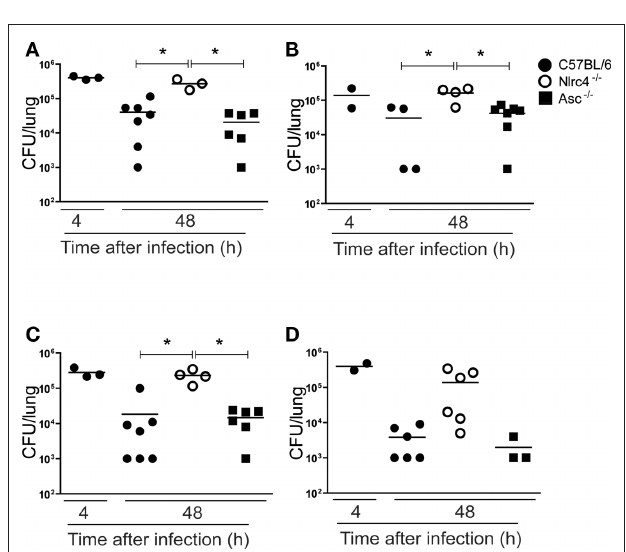
Figure 1 | Caspase-1 contributes for restriction of in vivo infection with L. micdadei , L. bozemanii , L. gratiana, and L. rubrilucens . C57BL/6 (closed circles) and caspase-1 − / − (open circles) mice were infected intranasally with 1.0 × 10 6 Legionella spp . per mouse. (A) L. micdadei . (B) L. bozemanii . (C) L. gratiana. (D) L. rubrilucens . Mice were sacrificed 4, 48, and 96 h after infection and dilutions of the lung homogenates were added to CYE agar plates for CFU determination. Each dot represents a single animal and the horizontal lines represent the average. Six to 10 mice were used per group. Data are representative of those found in four independent experiments. An asterisk indicates a P value of < 0.05.